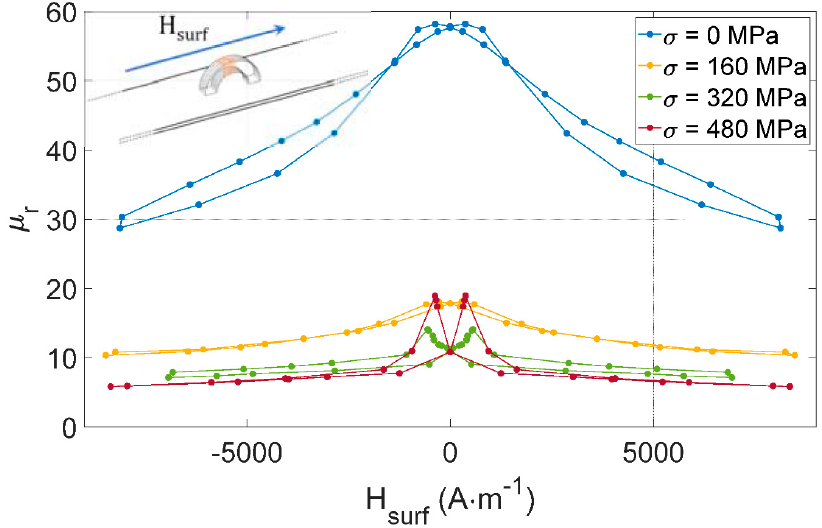
Figure 11. µ r (H surf ) for different tensile stress levels and with the MIP sensor aligned with the length of the tested specimen as illustrated in Figure 9.